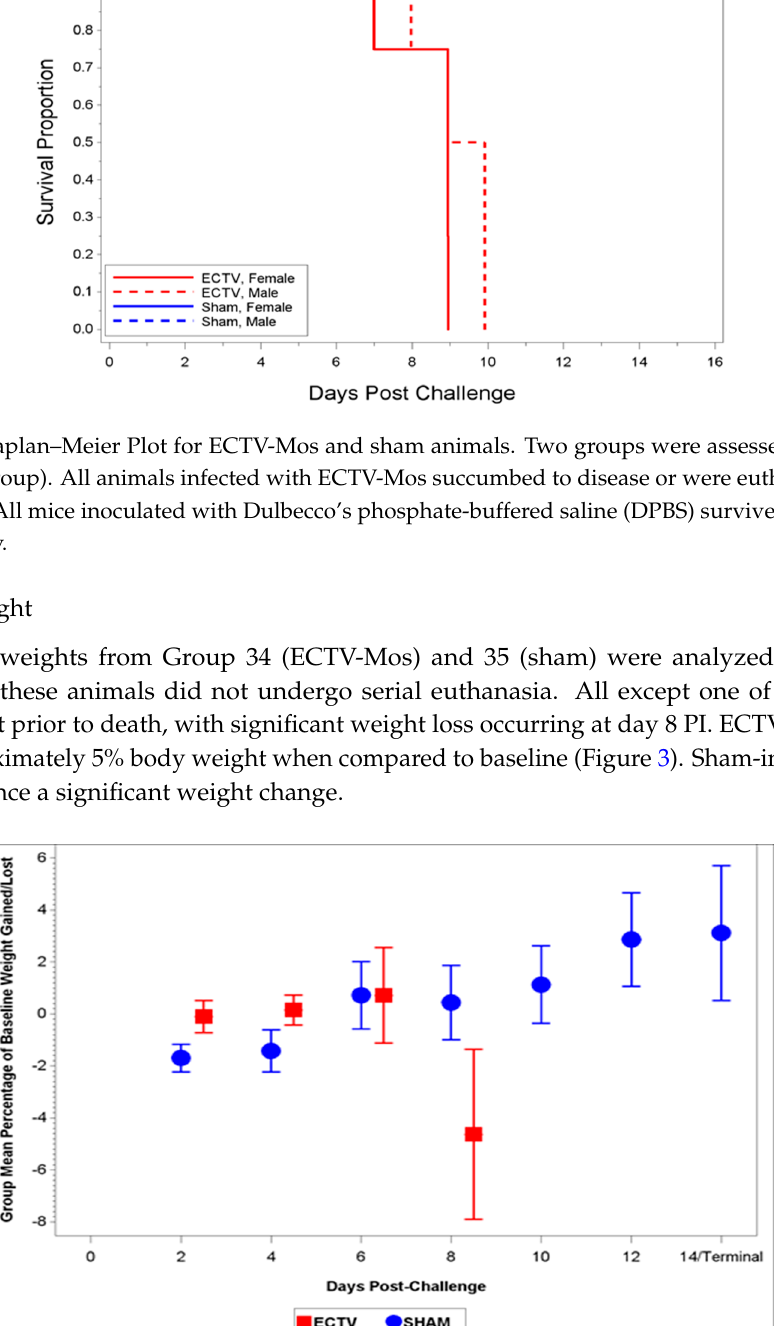
Figure 3. Change from baseline weight in BALB/c mice post ‐ infection. Significant weight loss in mice infected with ECTV ‐ Mos was observed at eight days PI. Sham ‐ inoculated, Group 35 mice lost a statistically significant amount of weight on day 2 and day 4 PI compared to baseline weights; however, these mice gained weight back by day 6.